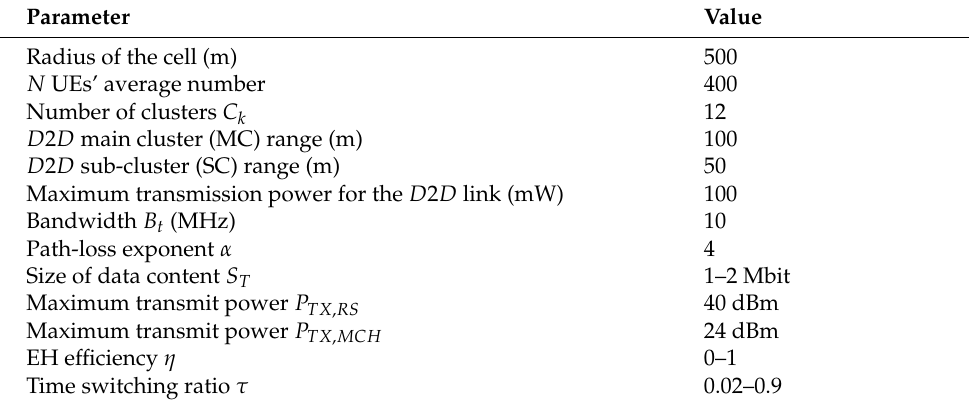
Table 1. Parameters for